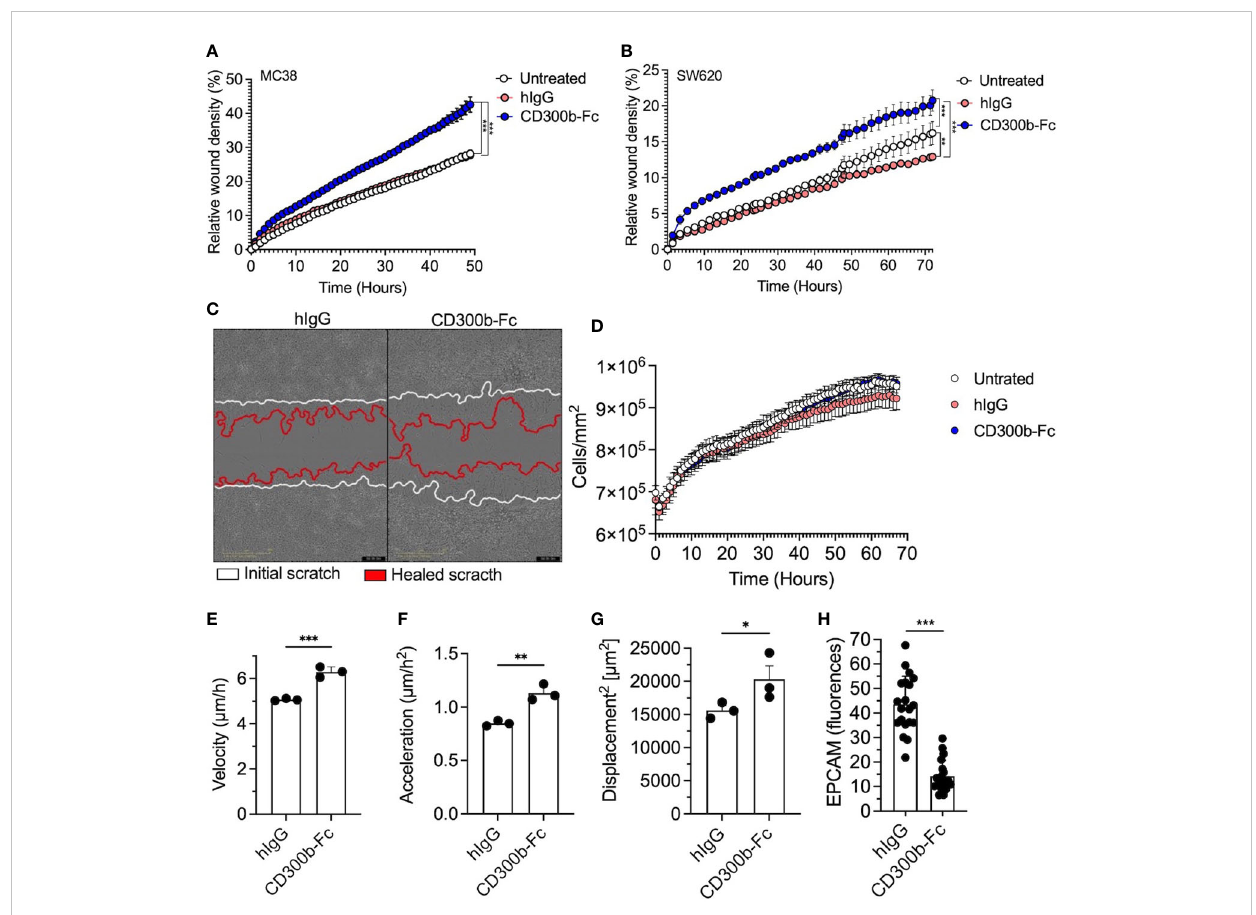
FIGURE 7 sCD300b promotes wound healing and regulates epithelial cell motility. MC38 and SW620 cells were incubated with CD300b-Fc fusion protein or hIgG and a scratch wound assay was performed. Relative wound density (A, B) and a representative photomicrograph of MC38-treated cells is shown (C) . Epithelial cell proliferation (D) , velocity (E) , acceleration (F) and displacement (G) were calculated from at least 100 single epithelial cells. Surface expression of EpCAM was determined by immuno fl uorescence (H) . Data are from n=3, *p<0.05, **p<0.01,